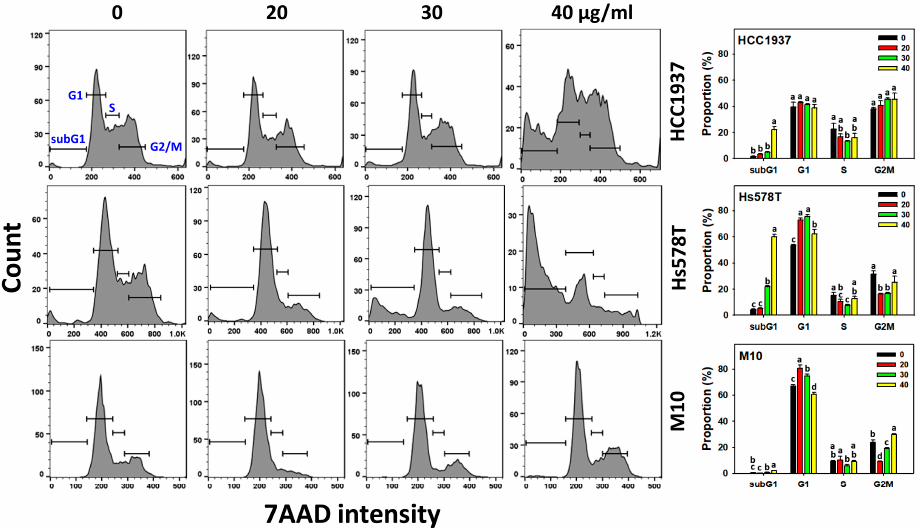
Figure 2. Cell cycle changes for 3HDT treatment. Cell cycle flow cytometry assay of 3HDT (control, 20, 30, and 40 μ g/mL) for 24 h was performed. Data: mean ± SD ( n = 3). Treatments differ significantly for multiple comparisons when the letters are not overlapping ( p < 0.05).